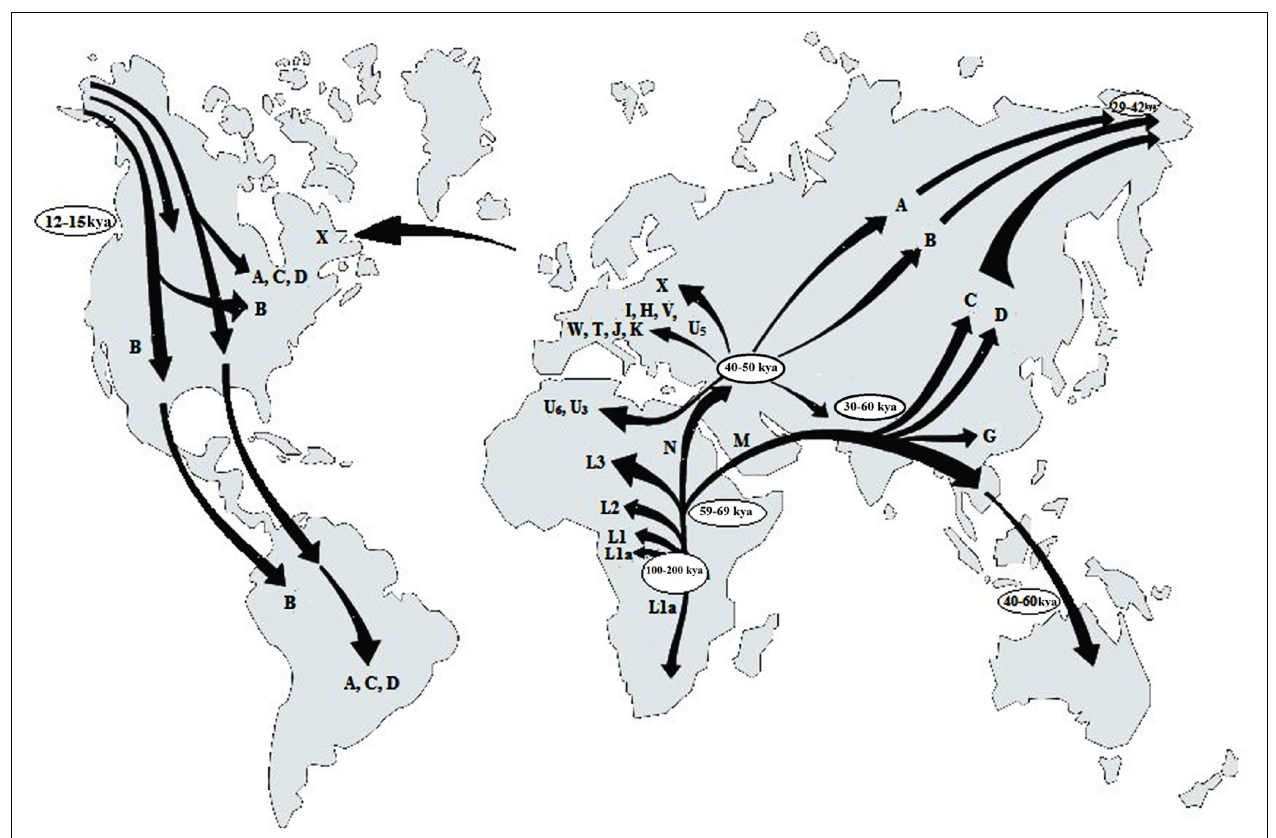
FIGURE 1 | Geographical distribution of the human mtDNA haplotypes (letters in map) deducing the origin of anatomically modern humans and presumable routes of human migrations “out ofAfrica” (adopted and modified fromWitas and Zawicki, 2004).